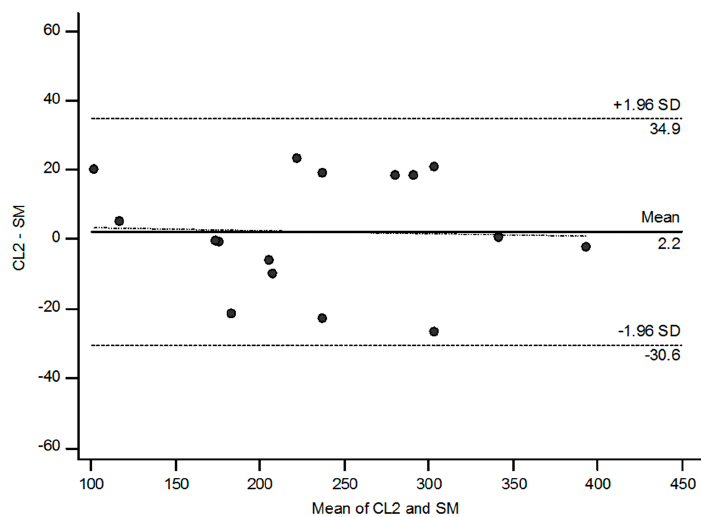
Figure 3. The Bland–Altman plot of the difference between the glomerular filtration rate (GFR) values measured by the reference method (two-compartment clearance: CL2) and simplified method (SM) versus the mean of both. The straight and dashed lines indicate mean difference and 95% limits of agreement, respectively.